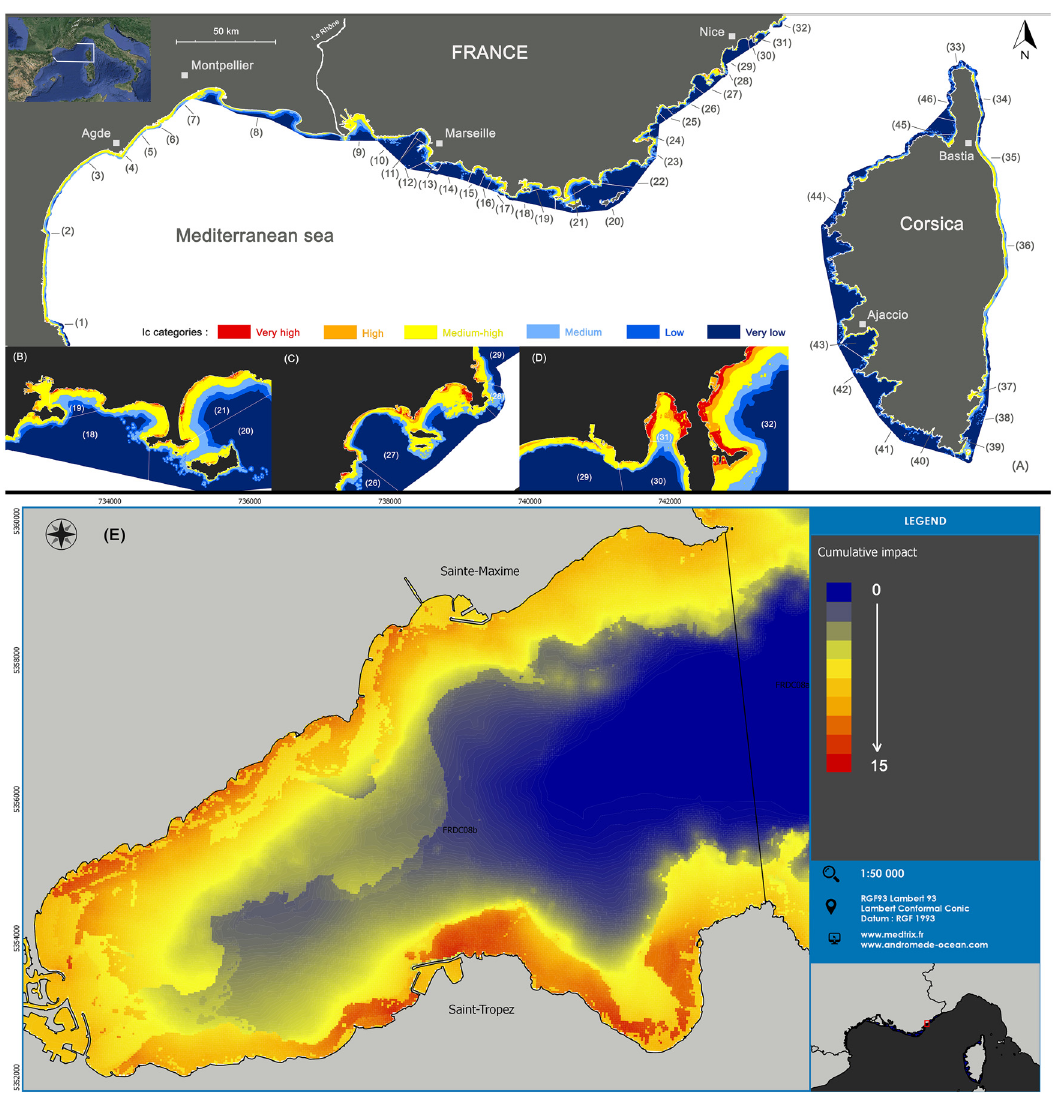
Fig 5. Spatial distribution of cumulative impact scores. (A) Spatial distribution of cumulative impact scores ( I C ) and localization of coastal water bodies. (B, C, D) Zooms showing how water bodies are more or less impacted ( I C categories). (E) Detailed map of the Golfe of St Tropez showing how the golfe is impacted (quantitative I C scores) Several cities are indicated by small